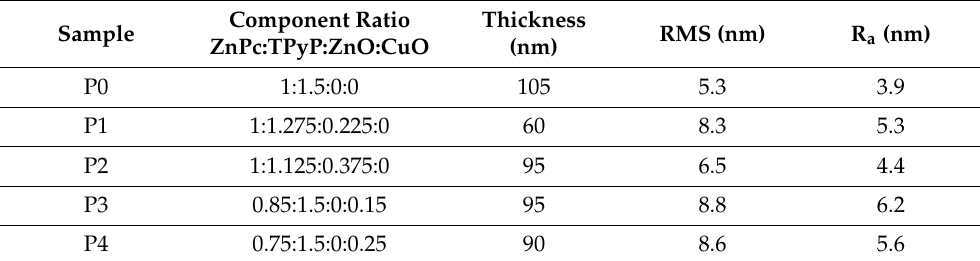
Table 1. The component ratio, thickness, and roughness parameters of the MAPLE deposited films.